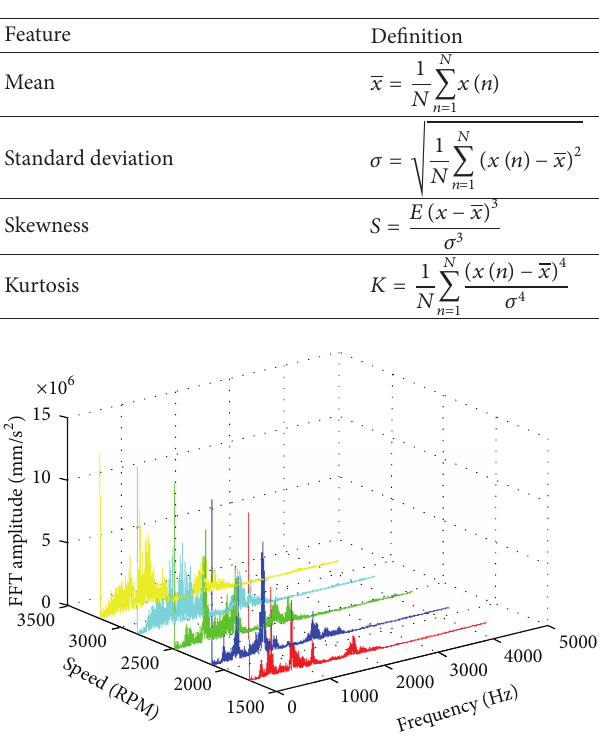
Figure 2: Frequency spectrum in function of the speed, under the following condition patterns: 375 W load, 𝑍 1 with face wear 0.4 [mm], 𝑍 2 with face wear 0.5 [mm], 𝐵 2 with 2 pitting on inner ring, and 𝐵 3 with 2 pitting on outer ring.